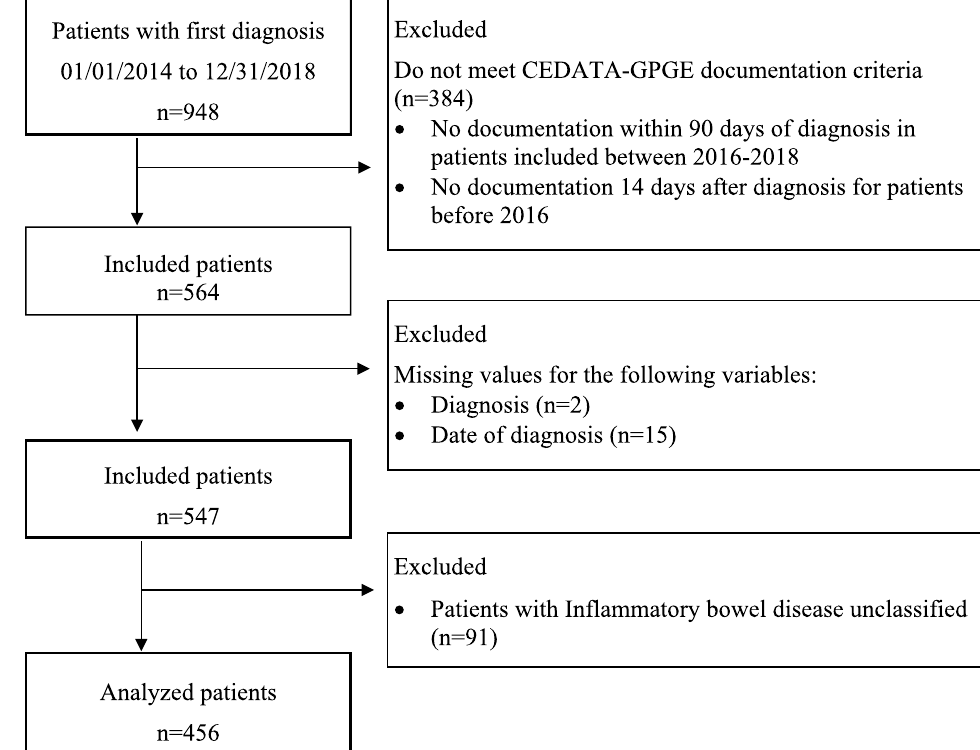
Figure 1. Flow chart of analyzed children and adolescents with IBD in the patient registry CEDATA-GPGE.